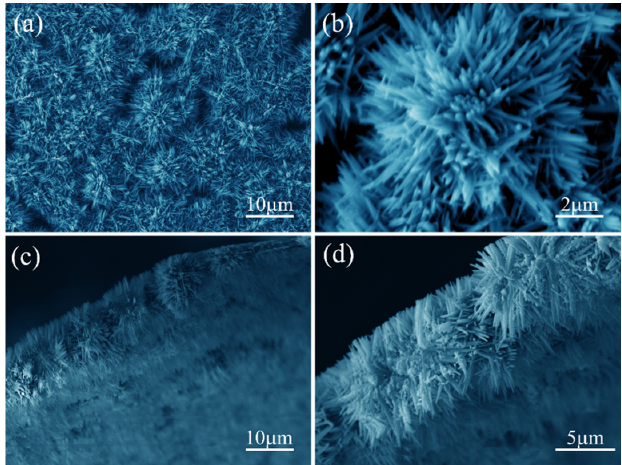
Figure 2. SEM images of TiO 2 nanoarrays grown on vertically placed ITO substrate: ( a ) Front view of TiO 2 nanoarray; ( b ) A magnified view; ( c ) TiO 2 nanoarray cross-section; ( d ) C magnified view.